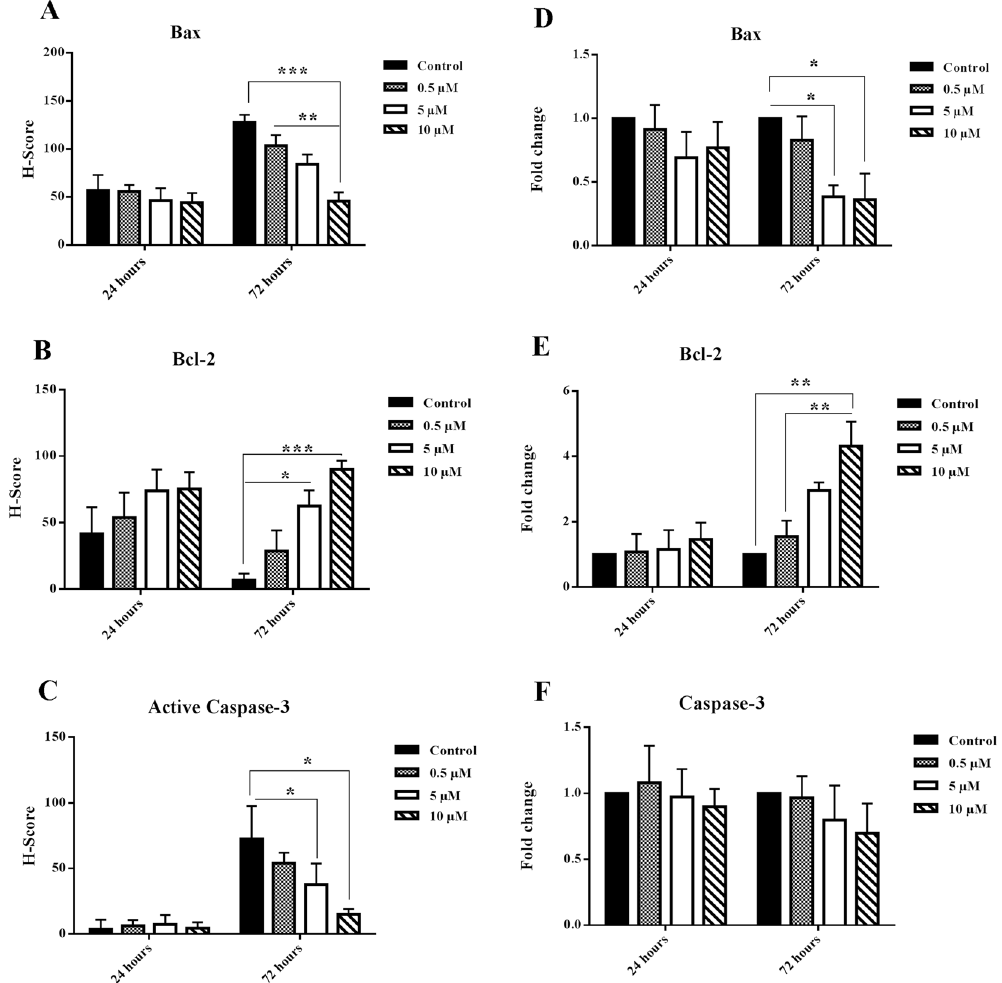
Figure 4. Pro-apoptotic and anti-apoptotic protein and gene expression. ( A – C ) Bax, Bcl-2, and active Caspase-3 protein in the islets in different concentrations of nobiletin that were calculated with H-score method, based on the percentage and intensity of the brown stained area in the islets. ( D – F ) Bax, Bcl-2, and Caspase-3 mRNA levels in different concentrations of nobiletin. The experiment was done in triplicate from four donors and data were analyzed by Kruskal-Wallis and Post-hoc tests. Results were represented as mean ± SD. * p < 0.05, ** p < 0.01, and *** p <